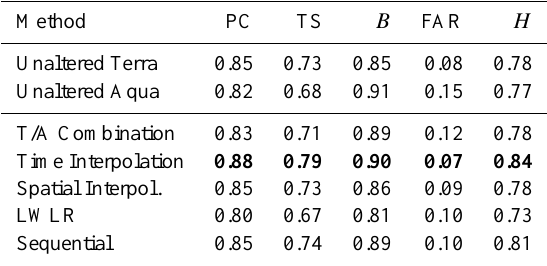
Table 2. Evaluation Statistics for the original images and individual results. The data in bold is the method with the best accuracy